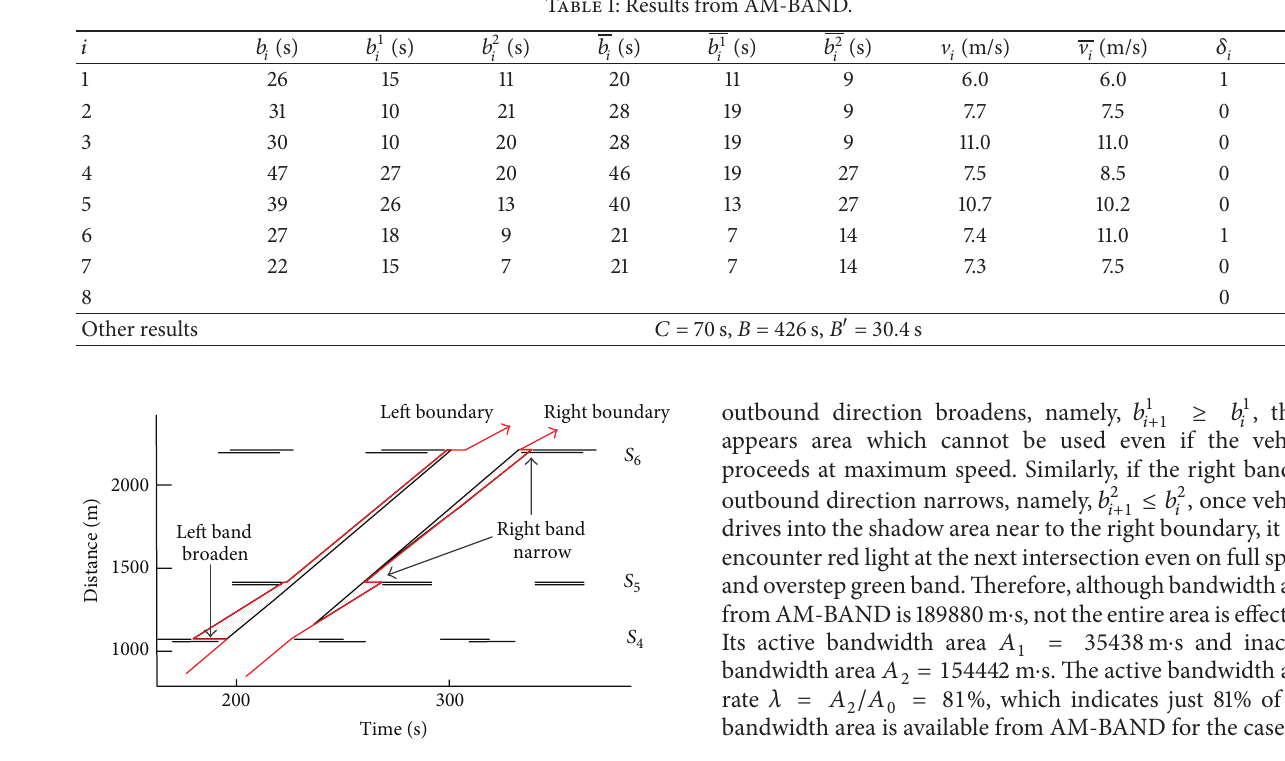
Figure 5: Inactive green band